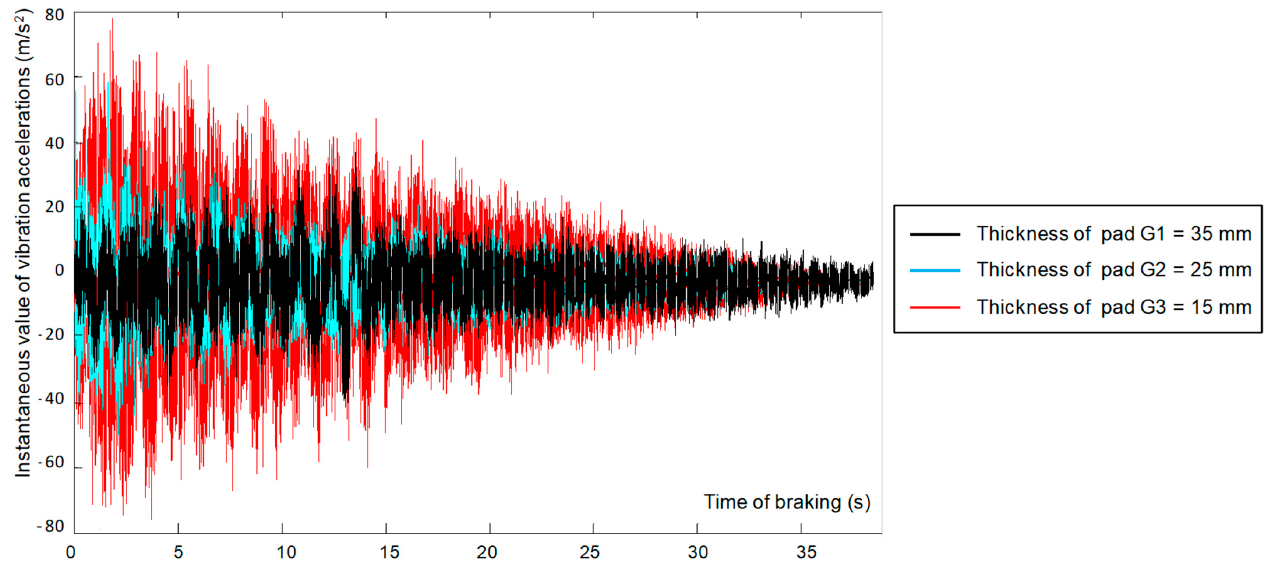
Figure 6. Signal of vibration accelerations registered on lining cladding for different thicknesses of linings during braking to stop (speed at beginning of braking v = 120 km/h).